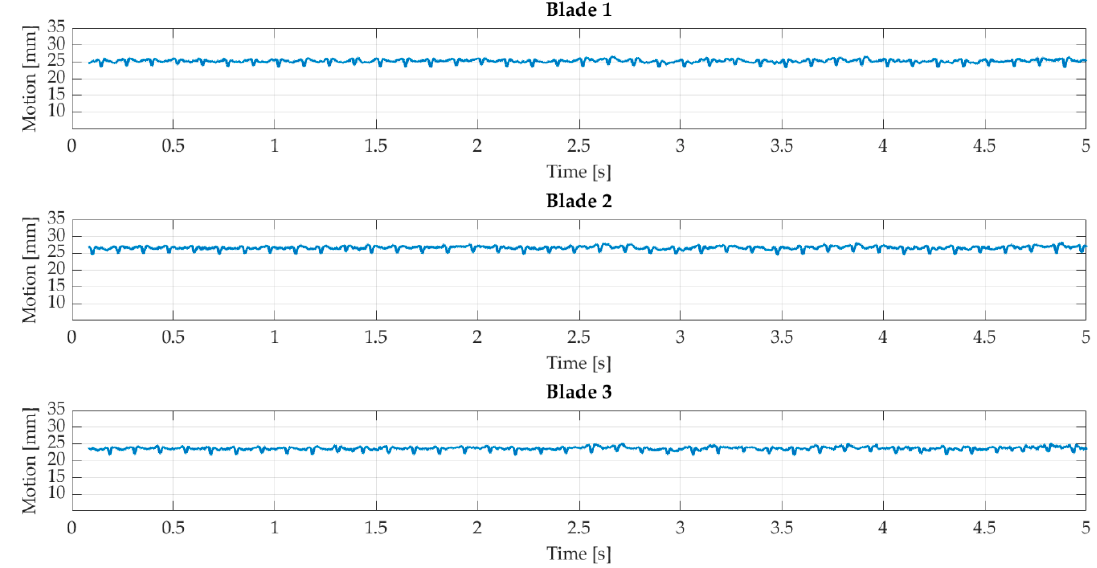
Figure 11. Blade deflection with steady inflow.